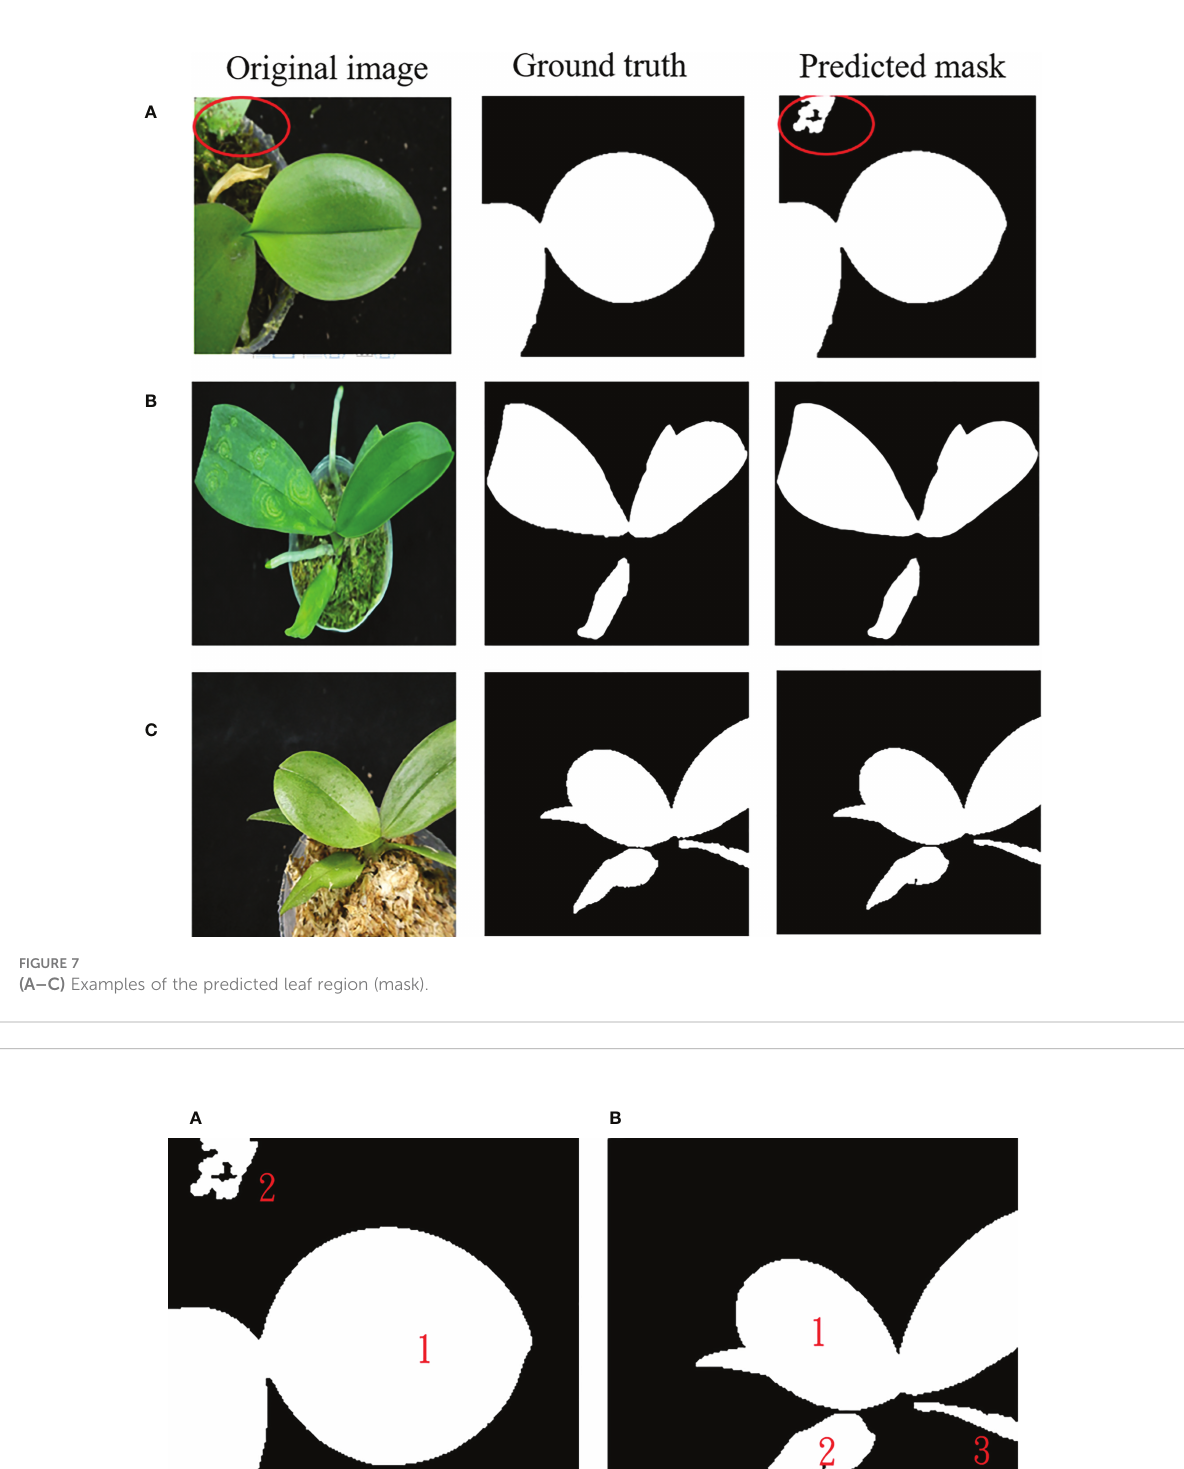
FIGURE 8 Results after performing the connected component labeling with (A) two connected regions and (B) three connected